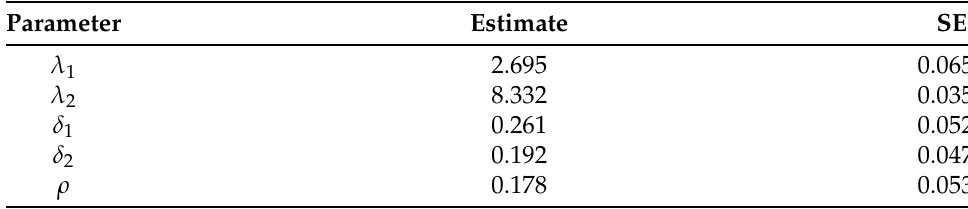
Table 6. Parameter estimates for the bivariate Poisson model.